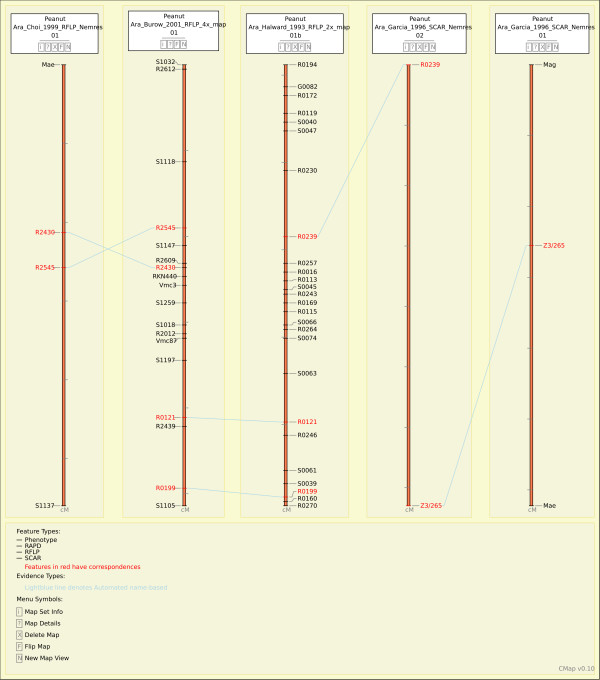
Co-display of phenotypic and marker data. The root-knot nematode resistance trait is denoted by 'Mae' and 'Mag', Meloidogyne arenaria resistance genes denoting reduced egg masses and reduced galling, respectively. Two linkage maps from genomic map sets are shown also, one of the tetraploid linkage group 1 and one of diploid linkage group 1b.